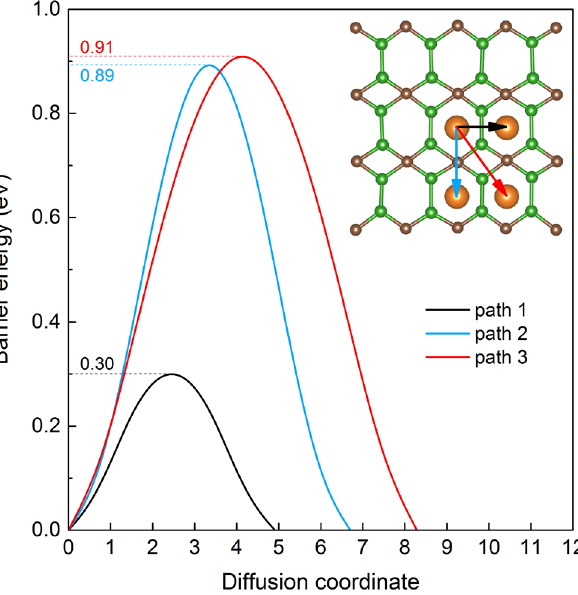
Figure 5. Migration barrier energies of Mg atom from the energetically stable absorption hole site to nearest hole site.